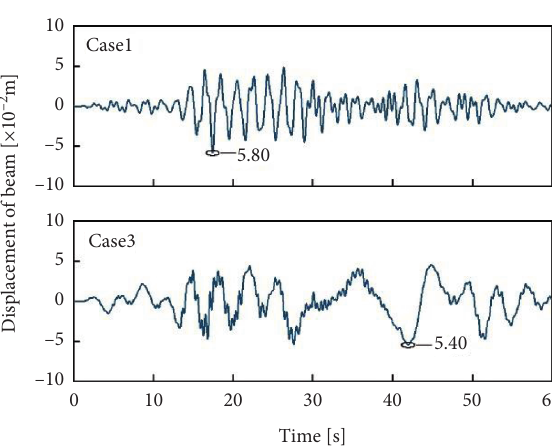
Figure 13: Displacement time histories of beam relative to pier No. 4 in Cases 1 and 3.